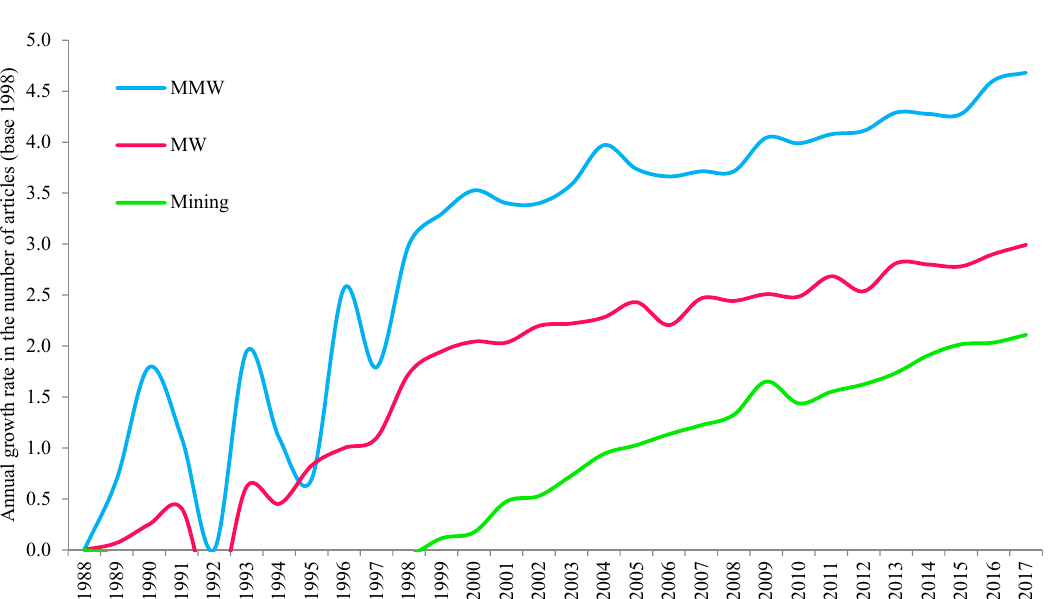
Figure 6. Comparative trends in the number of articles of mining, MW, and the management of mining waste (MMW) research.